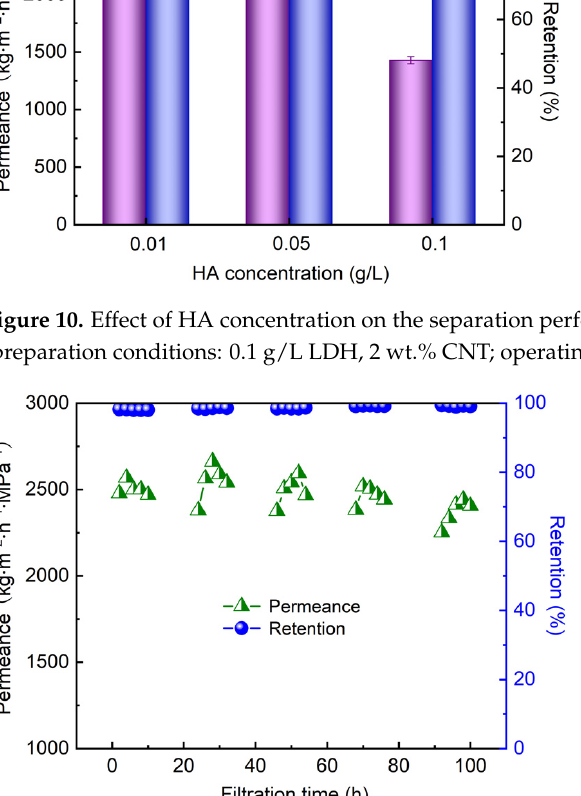
Figure 11. Stability test of CNTs/LDH composite membrane for HA removal (preparation conditions: 0.1 g/L LDH, 2 wt.% CNT; operating pressure: 0.1 MPa).